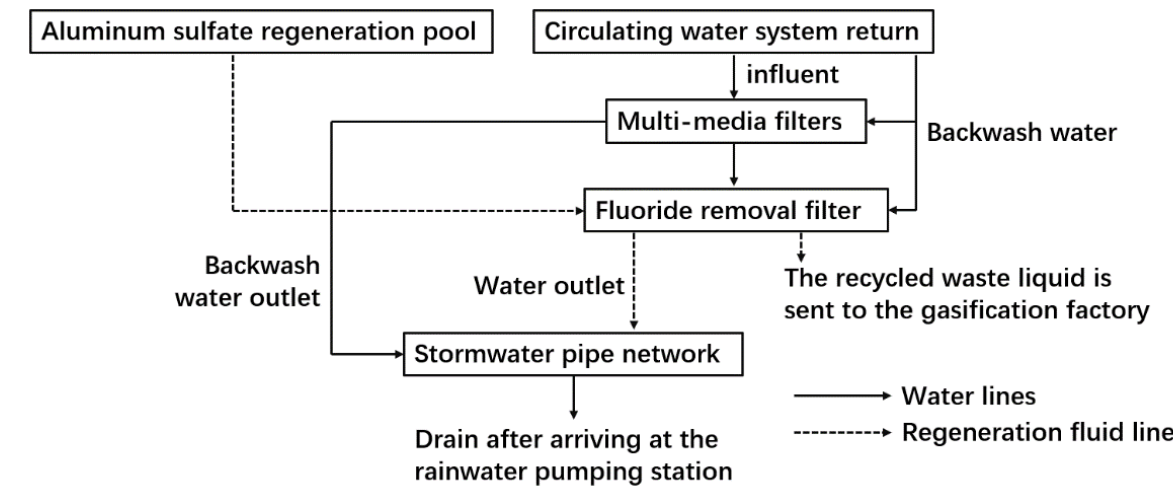
Figure 5. Flow chart of filtration−adsorption process.